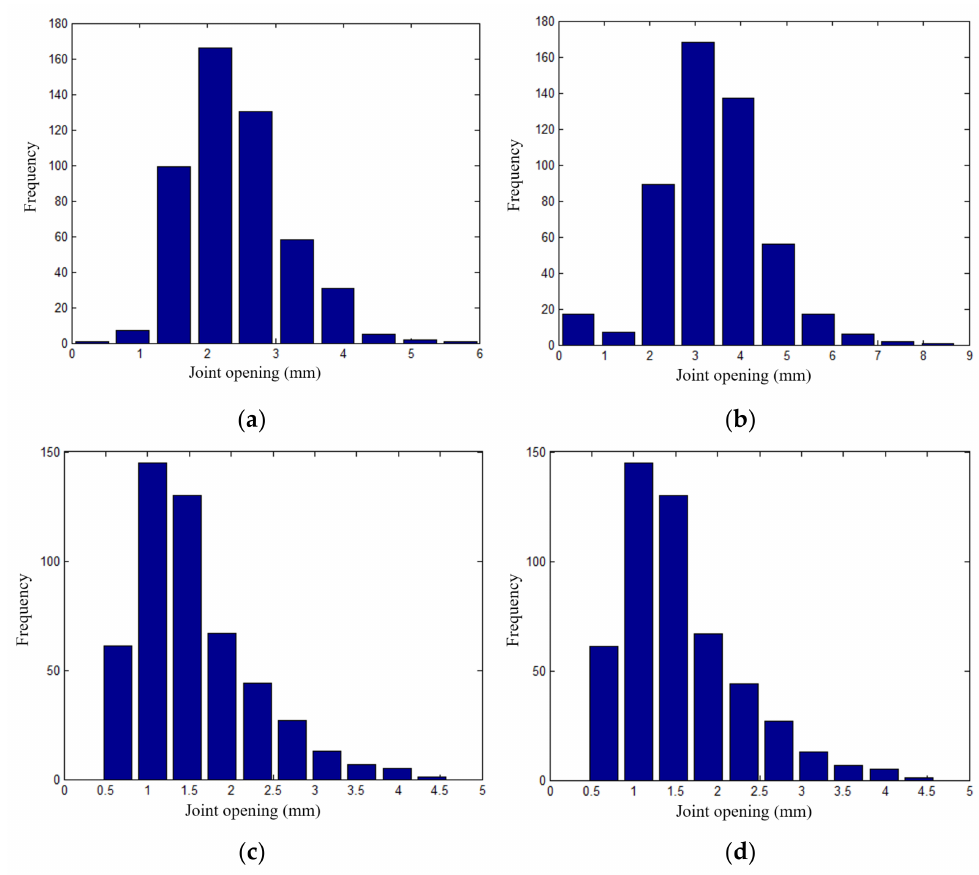
Figure 17. Error frequency distribution of the maximum joint openings in each ring after reducing σ rT and σ rR . ( a ) Maximum circumferential joint opening after the reduction in σ rT L L circumferential joint opening after the reduction in σ rR the reduction in σ rT ; ( d ) Maximum longitudinal joint opening after the reduction in σ rR L